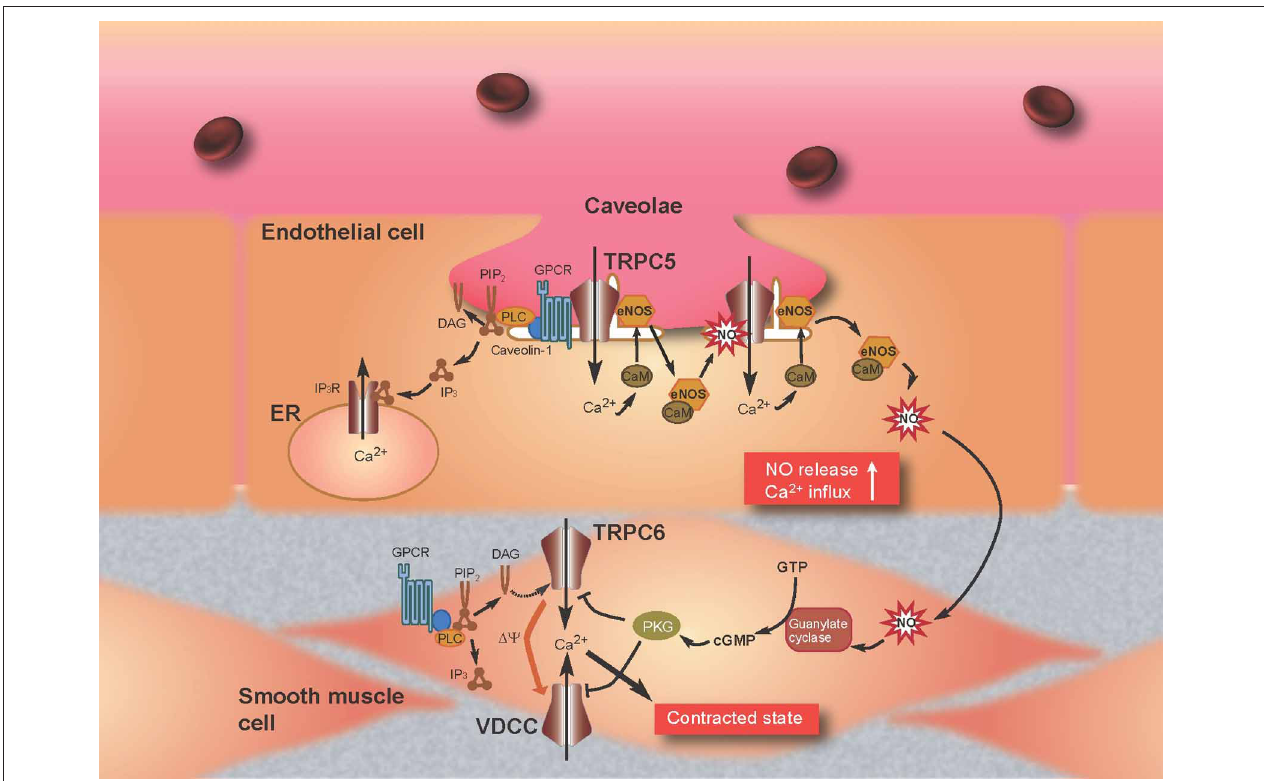
FIGURE 4 | Model for TRPC5-mediated feedback of Ca 2 + and NO signaling in endothelial cells and attenuation of Ca 2 + entry through TRPC6 by NO in smooth muscle cells. Stimulation of G protein-coupled receptors (GPCRs) (such as the ATP-activated P2Y receptor) induces Ca 2 + influx and activation of eNOS as a consequence of binding of Ca 2 + -CaM and release of eNOS from caveolin-1. TRPC5 undergoeseNOS-dependent S-nitrosylation after GPCR stimulation, resulting in amplified Ca 2 + entry and secondary activation of eNOS to amplify production of NO. NO diffuses out of endothelial cells into adjacent smooth muscle cells and stimulates the